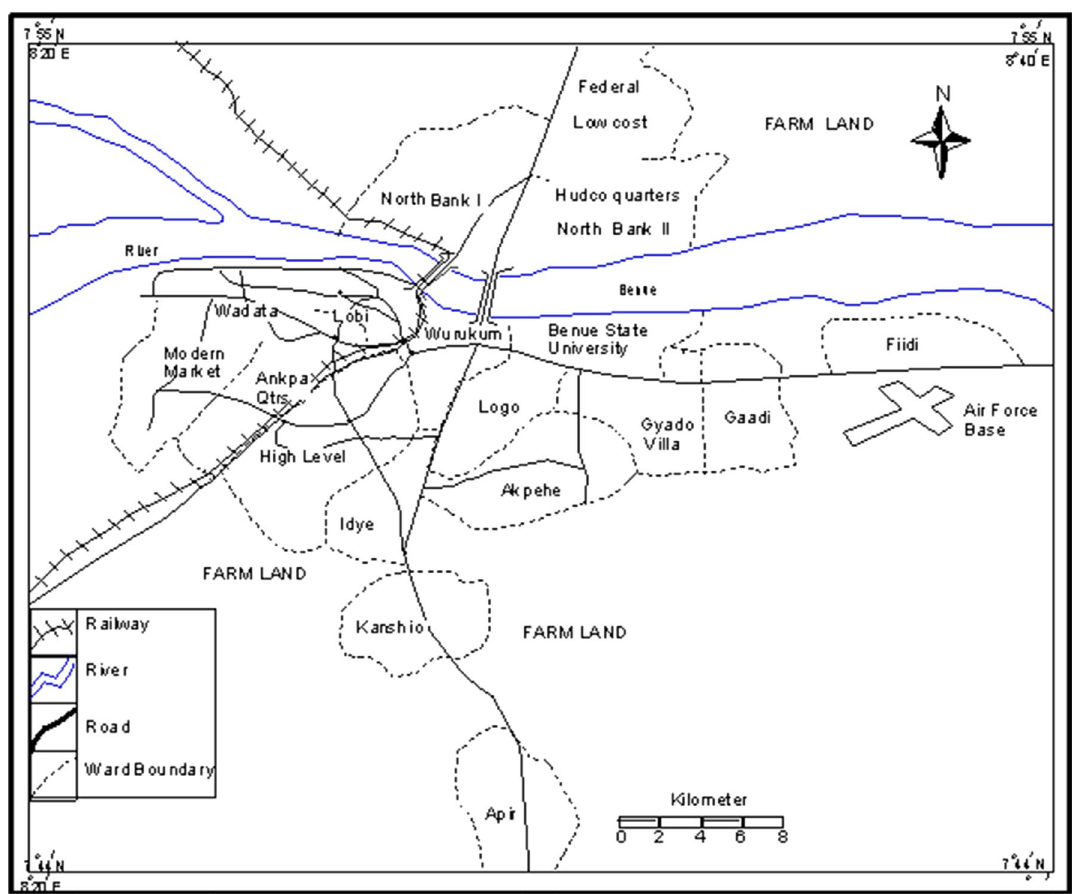
Fig. 1 Map of Makurdi town revealing the River Benue and its tributaries Source Benue State Ministry for Lands and Survey,